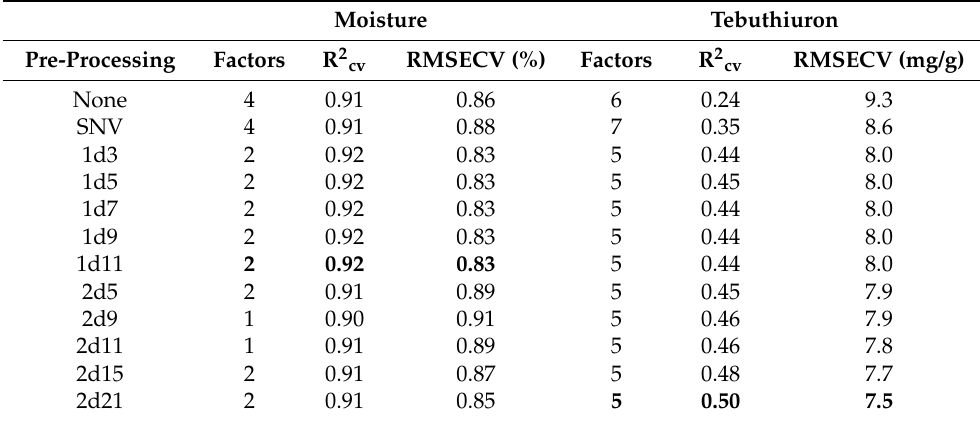
Table 9. Optimum pre-processing methods for the prediction of moisture and tebuthiuron content in Regain granules using the handheld MicroNIR instrument. The best-performing model for each analyte is highlighted in bold.